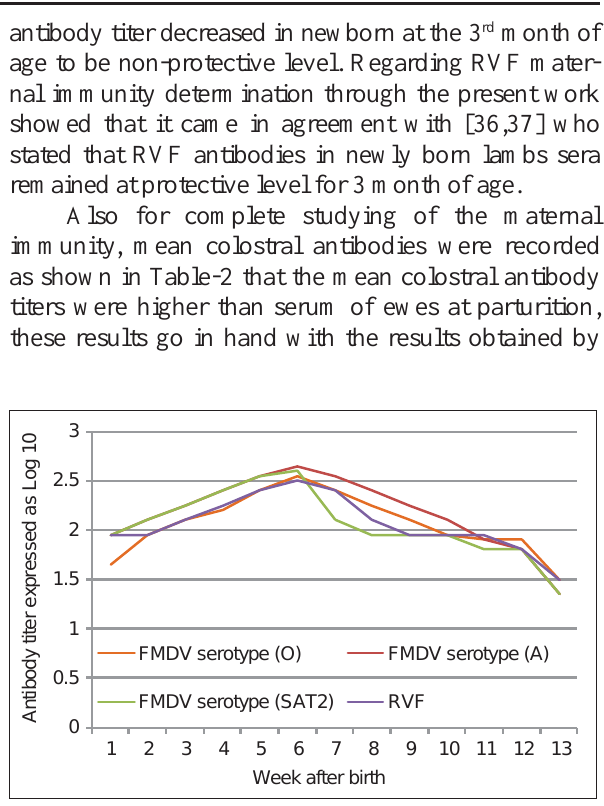
Figure-5: Mean antibody titers in newborn lambs from vaccinated ewes with combined Foot and Mouth disease/ Rift Valley Fever vaccine estimated by enzyme-linked immunosorbent assay.